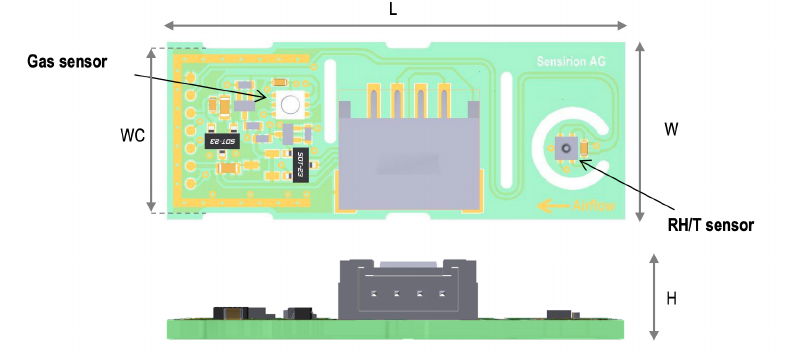
Figure 9. Smart Gas Sensing SOC